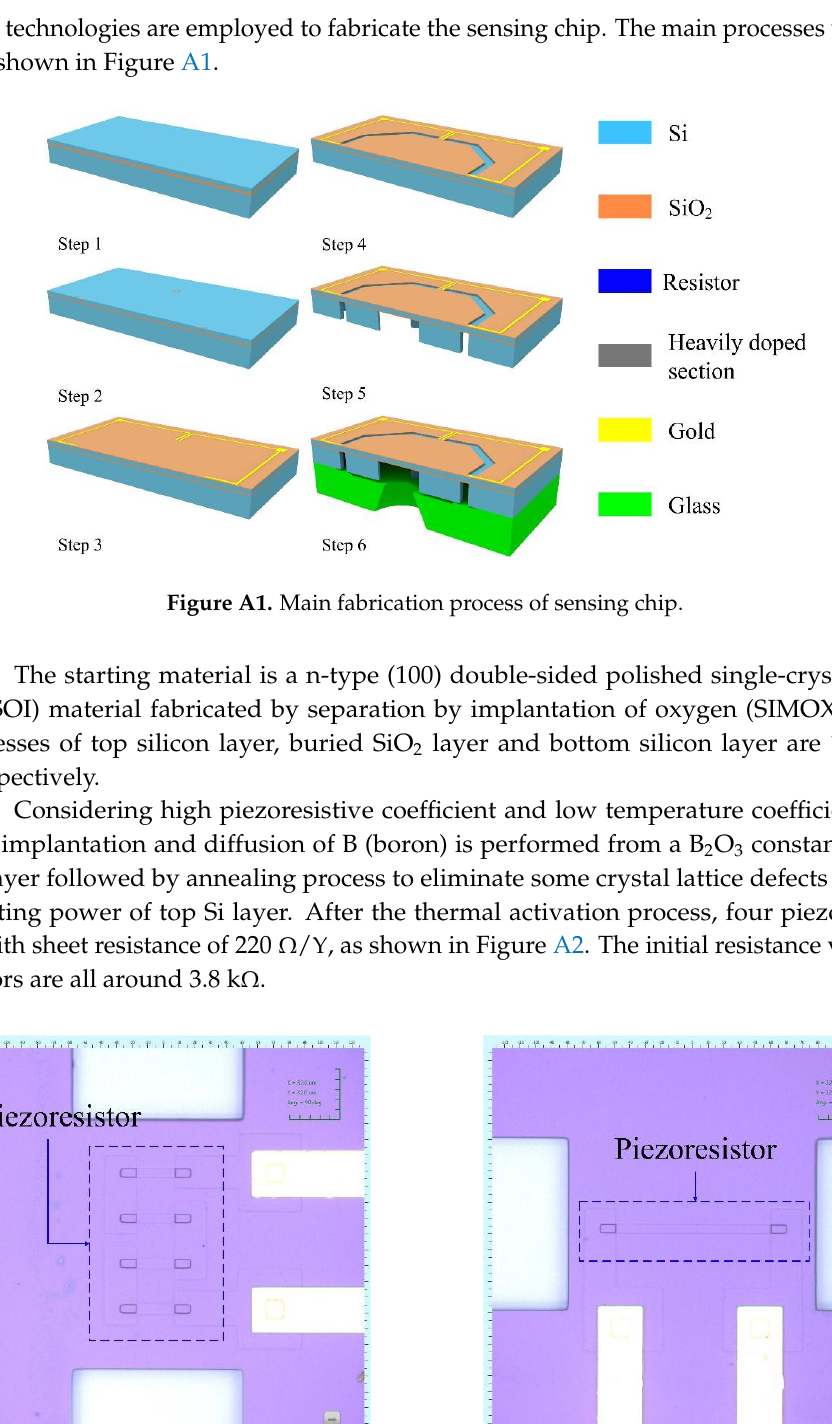
Figure A2. Microscopic photos of piezoresistors in two patterns: ( a ) piezoresistor in position 1 shown in Figure 16; ( b ) piezoresistor in position 2 shown in Figure 16.